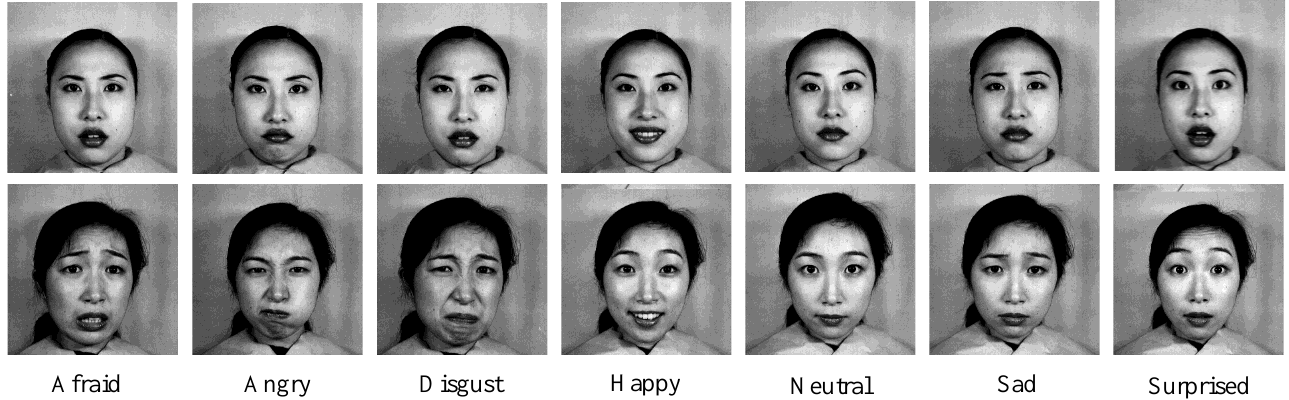
Figure 6. Sample images from JAFFE dataset.